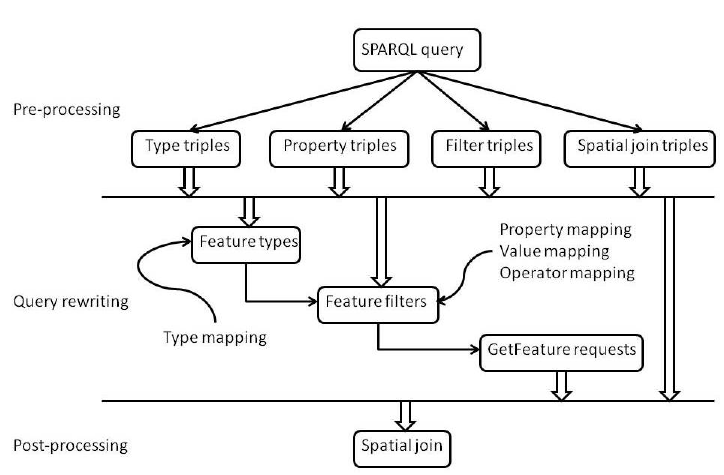
Figure 3. Overview of the query translation